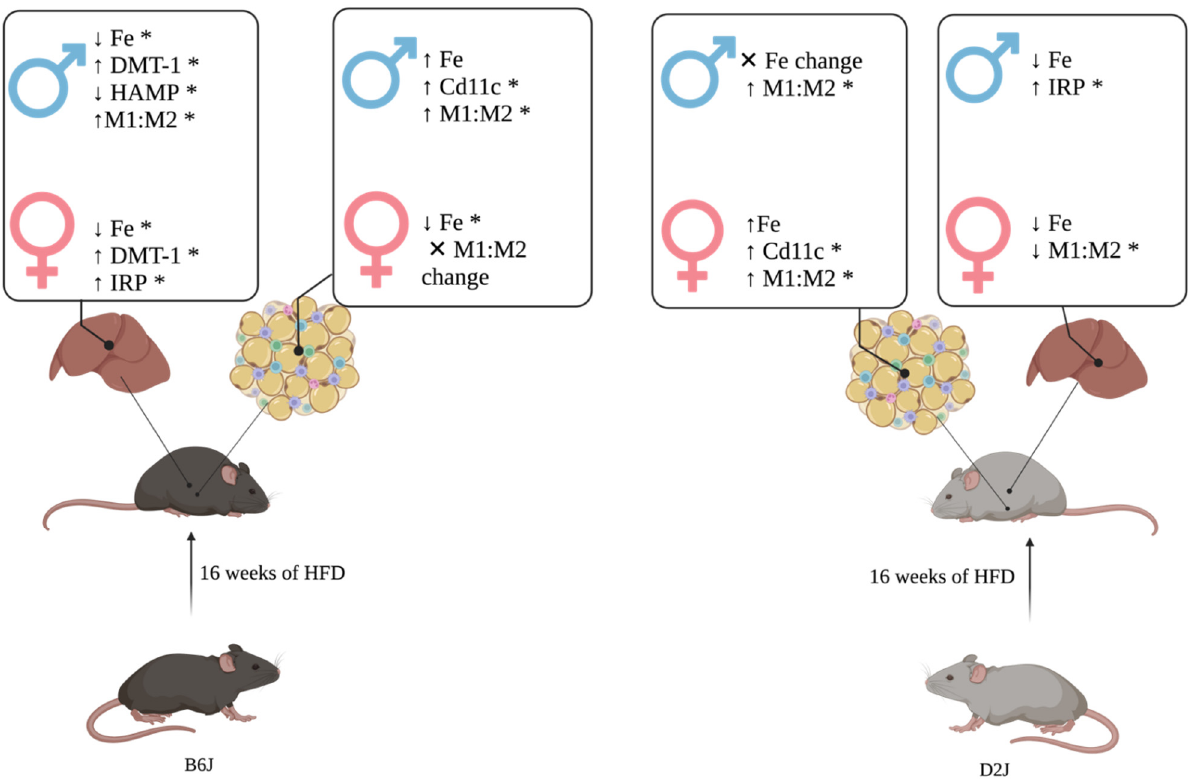
Figure 6. Summary model of the impact of a high-fat diet, sex, and strain on adipose and liver tissue iron concentration and iron-related gene expression. Following 16 weeks of a high-fat diet, B6J and D2J males and females experienced a significant weight gain and demonstrated significant alterations to adipose tissue and liver iron concentrations and related gene expression. Given the relevance of tissue iron concentrations to the development of local insulin resistance, our model focuses on HFD-induced alterations to tissue iron homeostasis. * p < 0.05. ↑ = increased, ↓ = decreased, Fe = iron, DMT-1 = divalent metal transporter 1, hepcidin= hepcidin, IRP = iron regulatory protein, M1:M2 = ratio of M1-like to M2-like macrophage gene expression. Figure created with BioRender.com.